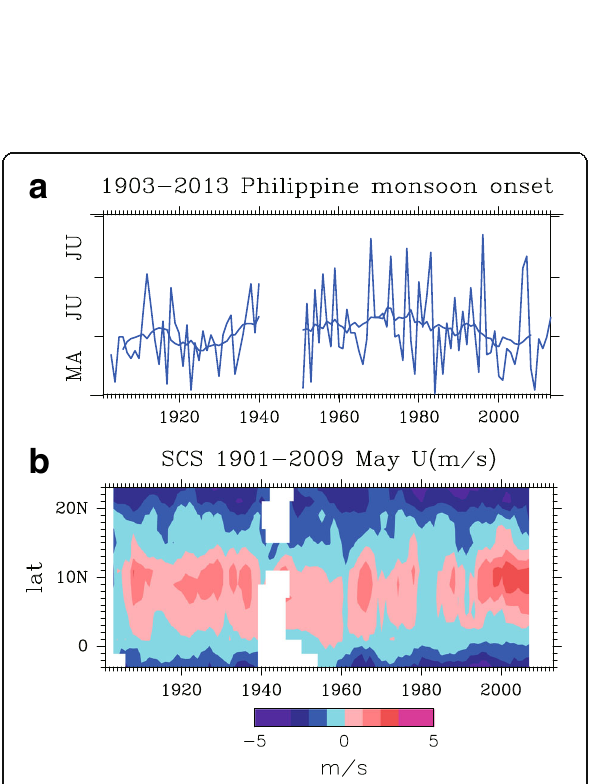
Fig. 5 Philippine summer monsoon onset date and surface zonal wind in May along the South China Sea. Time series of a Philippine summer monsoon onset date from 1903 to 2013 and b monthly surface zonal wind in May along the South China Sea from 1901 to 2007. Thick lines indicate an a 11-year or b 5-year running mean